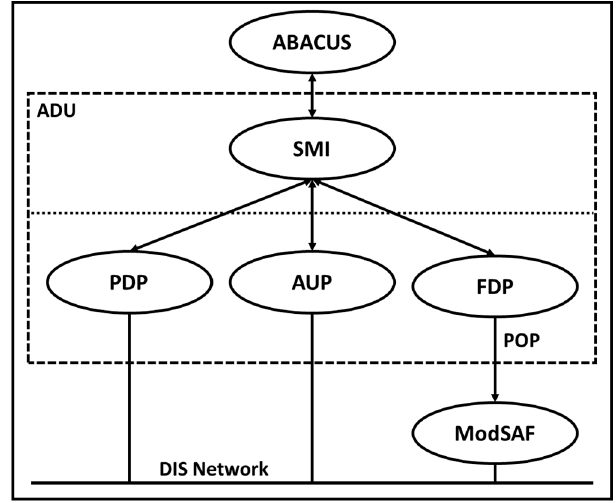
Figure 10. ADU structure (adapted from [40]).